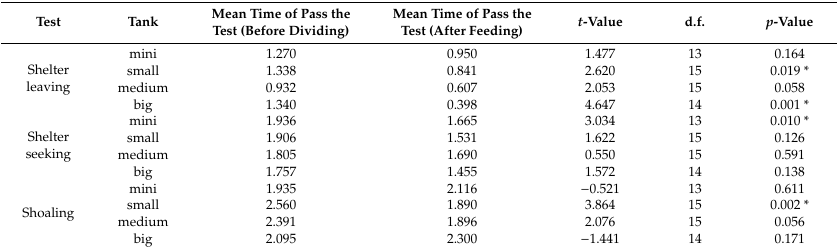
Table A1. Paired sample T test was performed on shelter leaving, shelter seeking, and shoaling tests prior to grouping and after 3 weeks of feeding. Significant di ff erences were found from the shelter leaving test in small and big tanks, shelter seeking test in mini tank, and shoaling test in small tank. The significance level was set at * p <